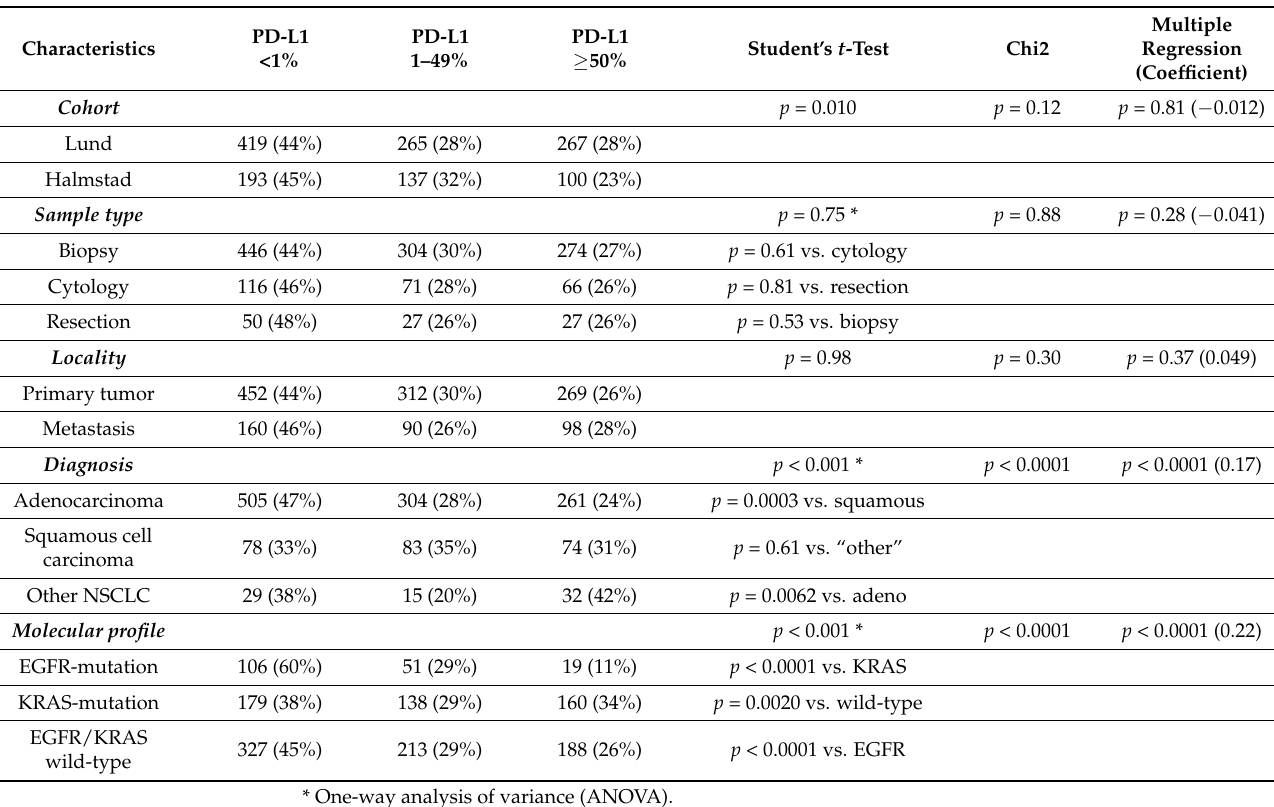
Table 2. Correlation of factors to PD-L1 expression in the 1381 lung cancer specimens with complete data.